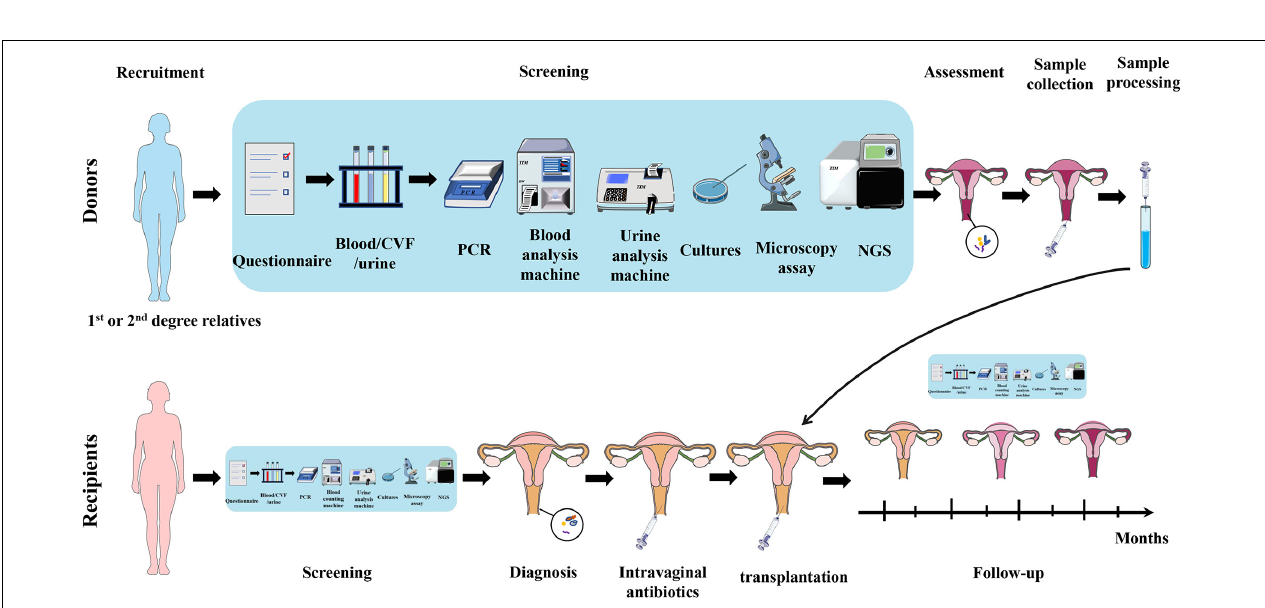
FIGURE 2 | Therapy effects of restoring Lactobacillus -dominated vaginal microbiota in non-infectious diseases. Lactobacillus -dominated vaginal microbiota cannot only benefit vaginal health by preventing vaginal infections and creating a non-inflammatory environment but also prevent pathogens in the vagina moving to the cervix and uterus. Besides, vaginal Lactobacillus can move to the upper reproductive tract, preventing pathogens infecting the cervix and uterus, and creating a non-inflammatory cervical and uterine environment.